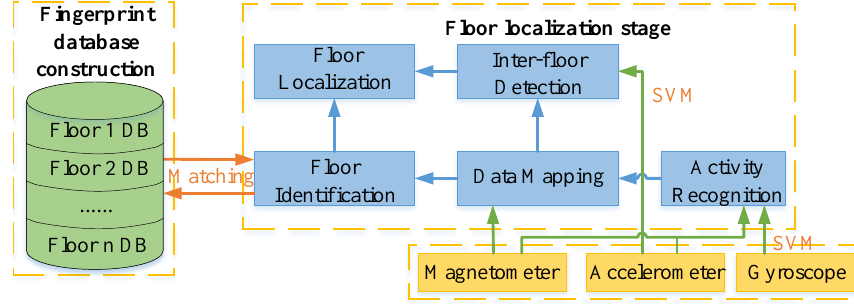
Figure 1. The overall structure of